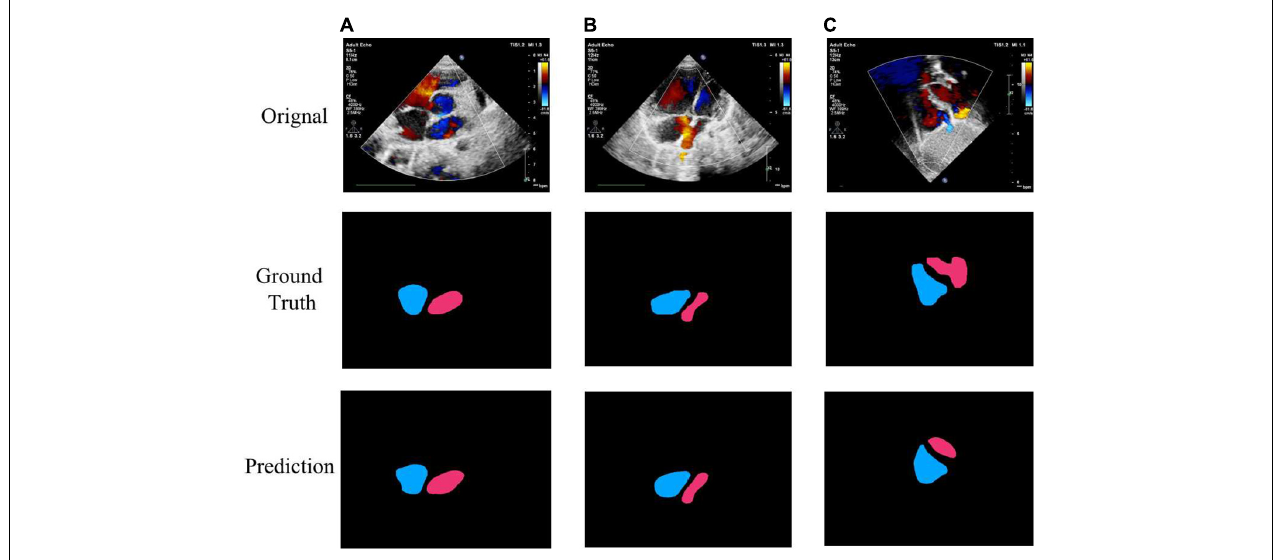
FIGURE 7 | Example segmentation results of cardiac anatomy. (A) High precision segmentation of DSC 0.9517; (B) medium precision segmentation of DSC 0.9115; (C) poor segmentation performance of DSC 0.7347.